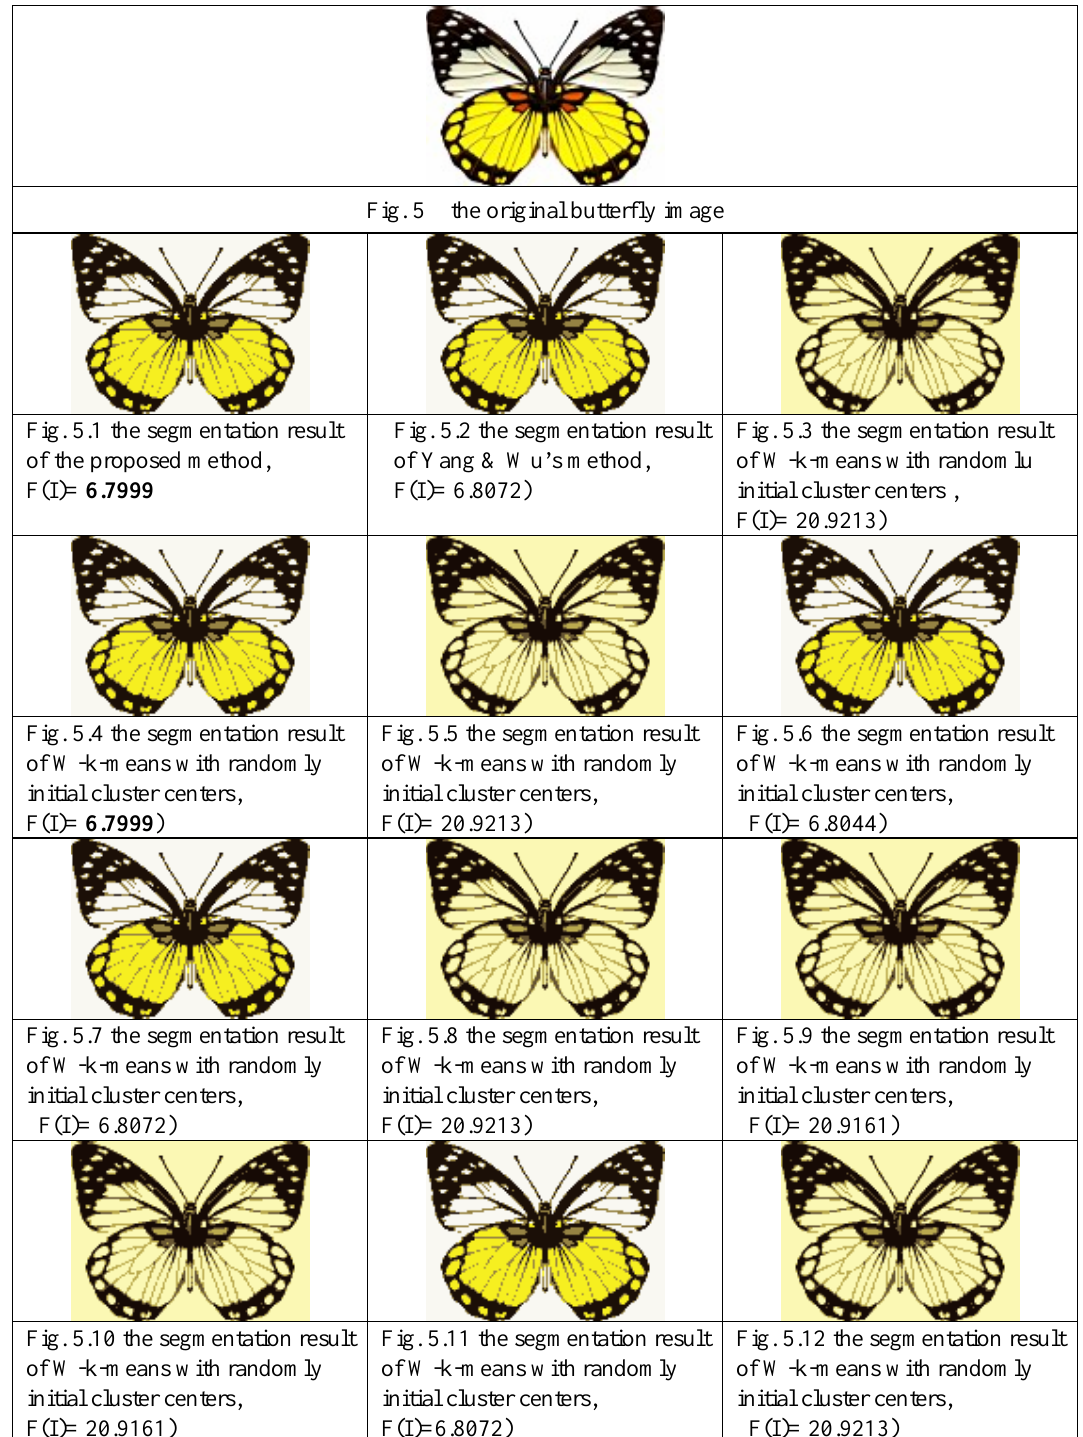
Fig. 5.11 the segmentation result Fig. 5.12 the segmentation result of W-k-means with randomly initial cluster